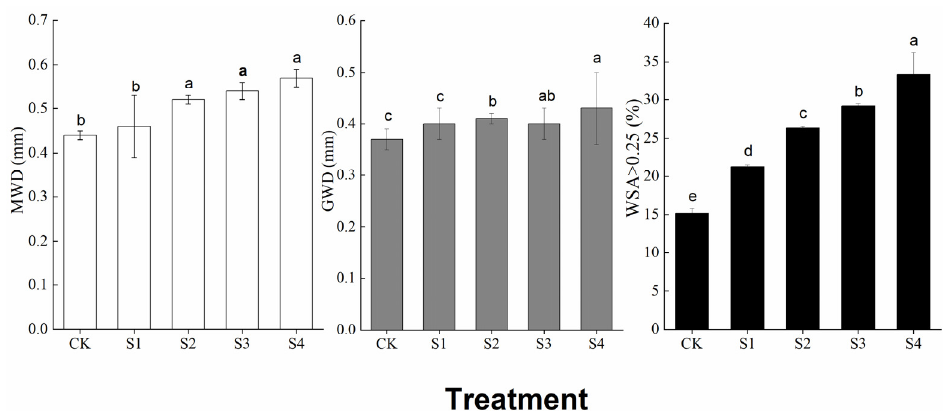
Figure 2. Effects of straw return on the size classes of soil aggregates. Different letters within a size fraction denote significant differences between treatments ( p < 0.05). CK, S1, S2, S3, and S4 represent rates of return of corn straw of 0, 6000, 9000, 12,000, and 15,000 kg hm − 2 , respectively. >2.00 mm, large macroaggregates; 2.00–0.25 mm, small macroaggregates; 0.25–0.053 mm, microaggregates; <0.053 mm, silt plus clay.